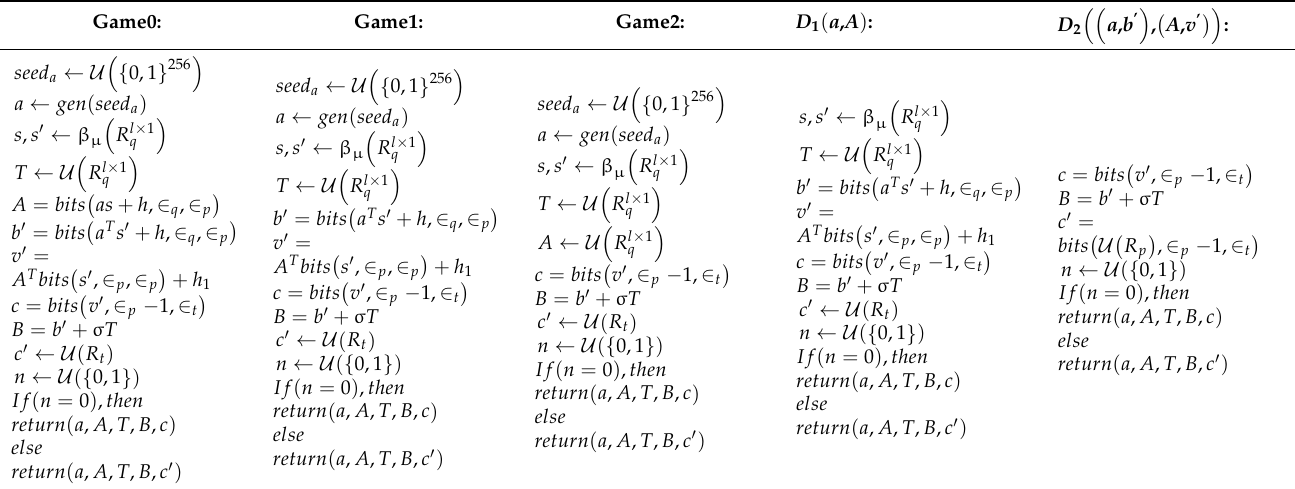
Table 3. The games mentioned in Proof of Theorem